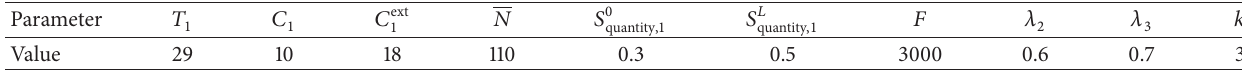
Table 2: Basic data (1).